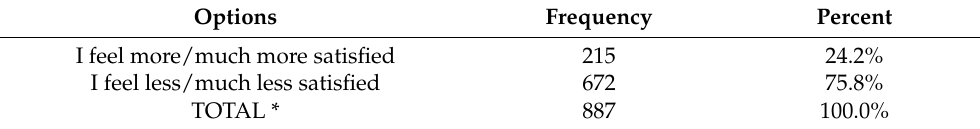
Table 4. In general, how do you feel about your experience of attending classes from home? Options Frequency Percent